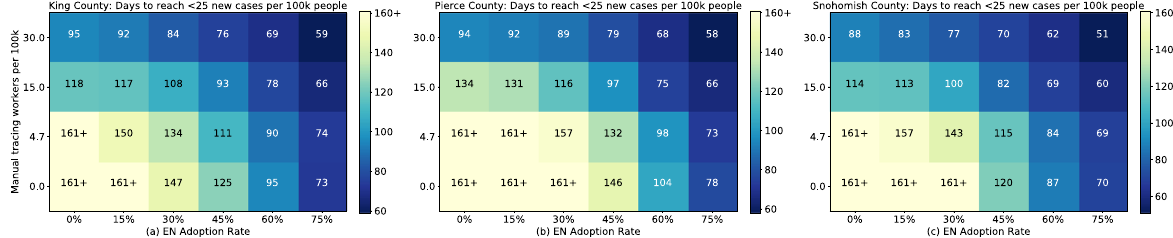
Fig. 7 Days to key metric under varied intervention levels. Estimated number of days from July 11, 2020 for King, Pierce, and Snohomish counties to reach the Washington state goal of fewer than 25 new cases per 100,000 people over the trailing 14 days, as a function of manual tracing workforce capacity and exposure noti fi cation app adoption, given a renewed lockdown to the average level over the month before June 5th. Simulated results shown for King ( a ), Pierce ( b ), and Snohomish ( c ) counties show the ability of the interventions to suppress the epidemic by the primary reopening